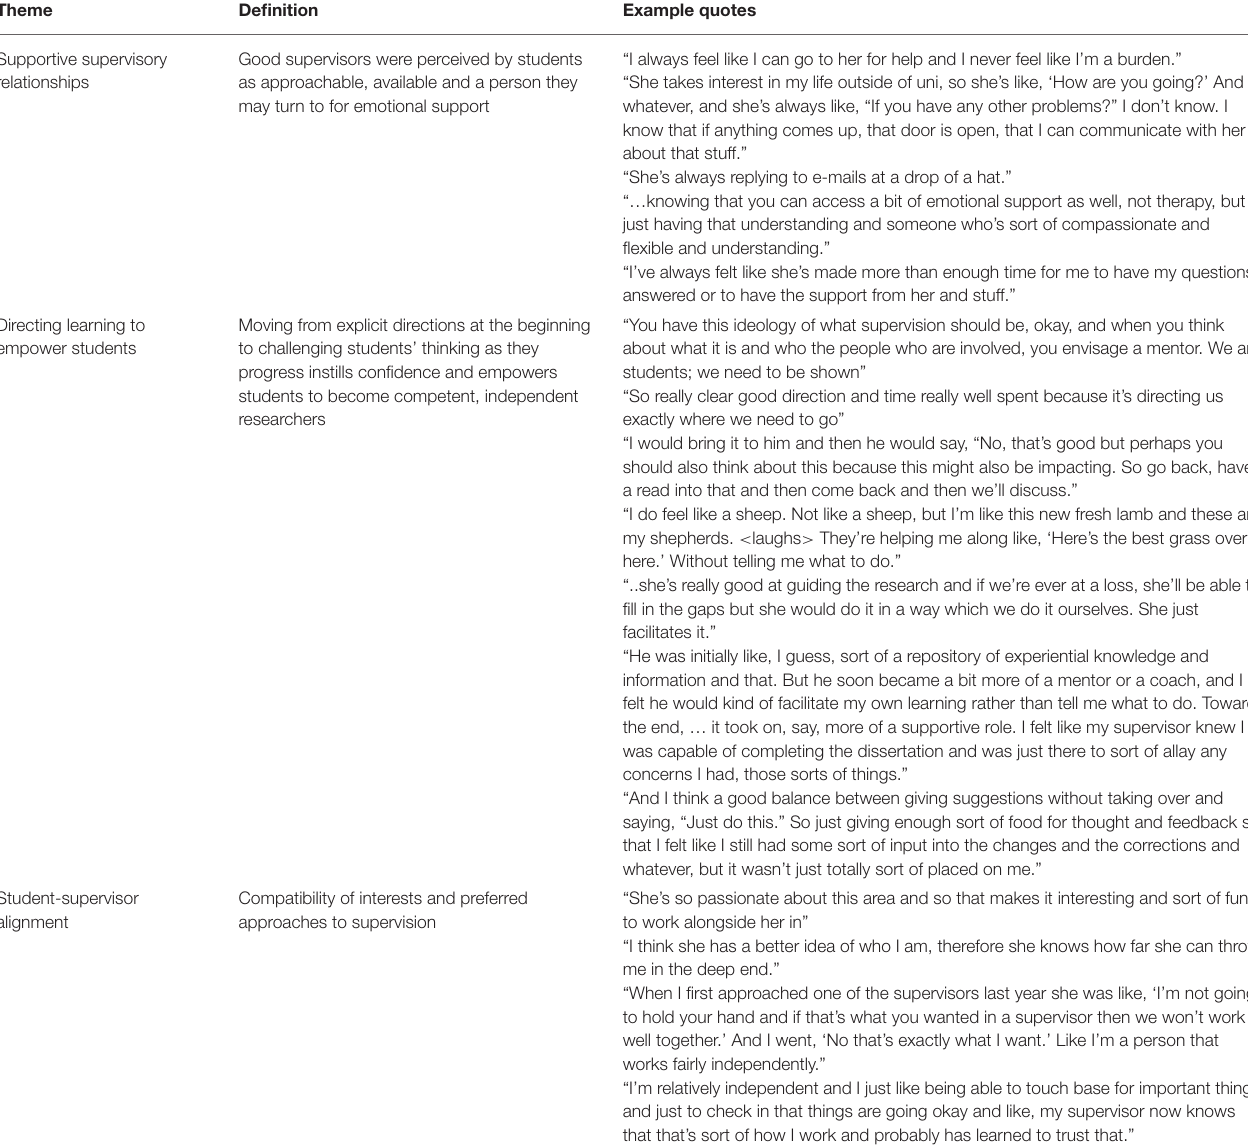
TABLE 1 | Themes underlying students’ perceptions of good